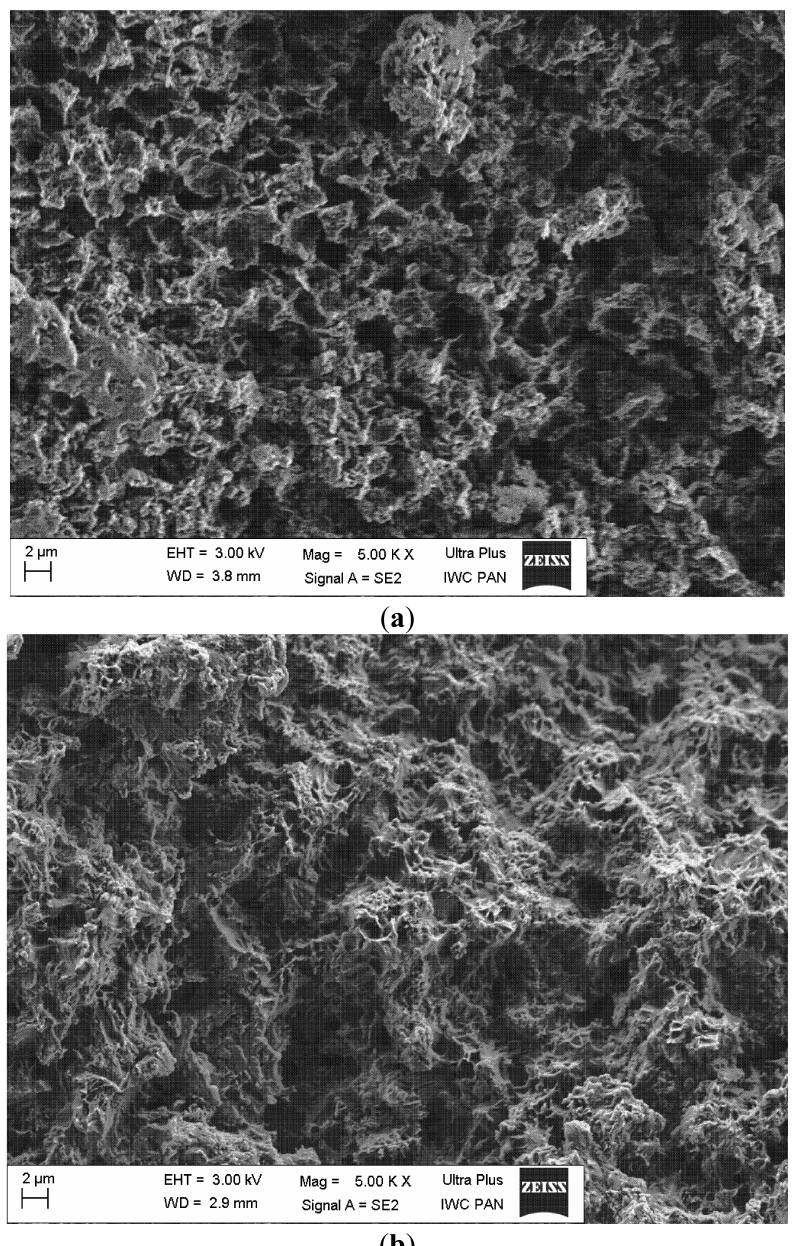
Figure 11. SEM micrographs of the polyurethane/hydroxyapatite composite. ( a ) before the degradation process; ( b ) after eight weeks’ degradation